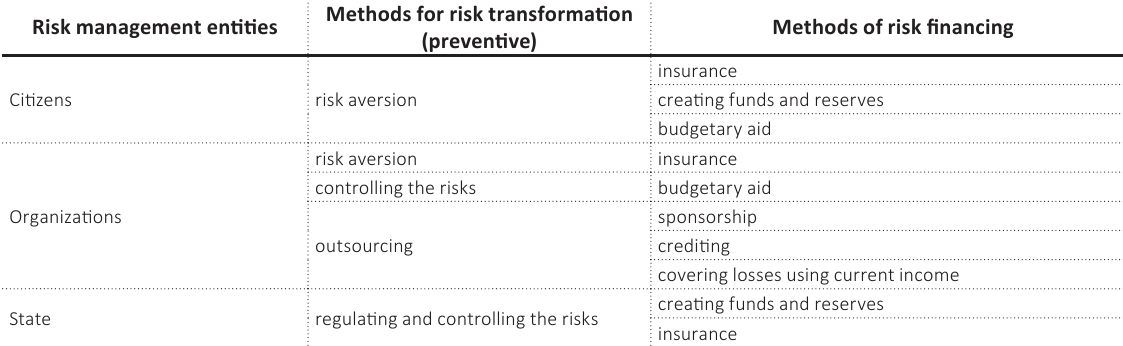
Source: Chernova